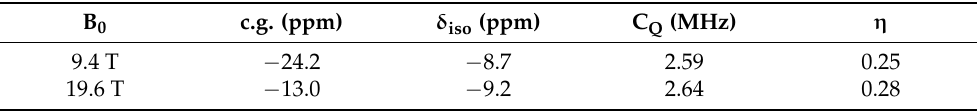
Table 14. NMR parameters from the simulation of the 23 Na spectra of specimen CLBR at three external magnetic fields (B 0